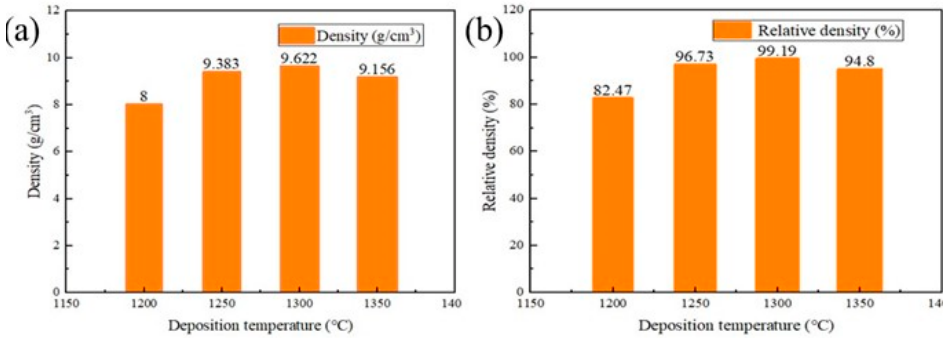
Figure 8. The relationship between the deposition temperature and the density and relative density of HfO 2 coatings. ( a ) is density and ( b ) is relative density.